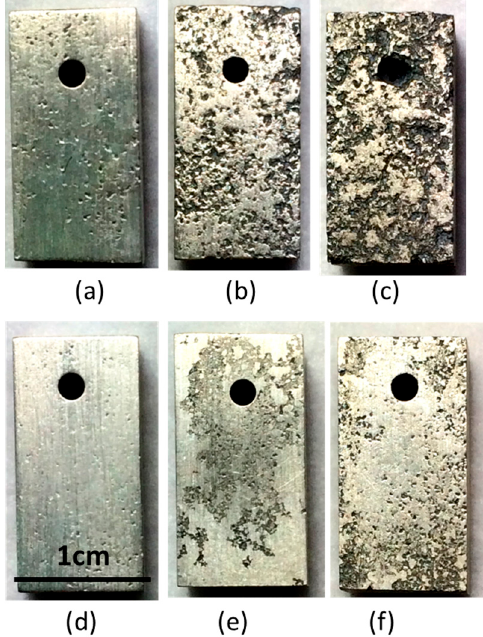
Figure 9. Macro corrosion morphologies of the MgZnY-C alloy immersed in simulated body fluid (SBF) for ( a ) 24 h; ( b ) 72 h; and ( c ) 120 h; and of HA-C alloy immersed in SBF for ( d ) 24 h; ( e ) 72 h; and ( f ) 120 h.